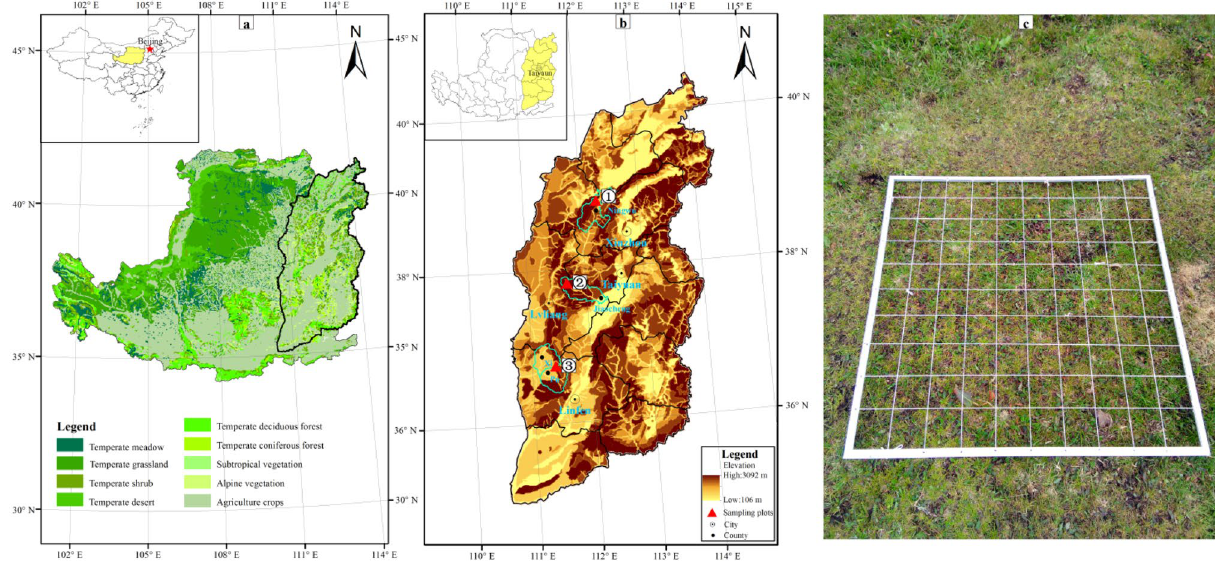
and 4 elevations were observed at Guancen Mountain ( ① ), Guandi Mountain ( ② ), and Wulu Mountain ( ③ ), respectively. In the interior of the frame, 100 grids were separated to accurately measure plant frequency and coverage. ( a ) and ( b ) were created by using ArcMap 10.2 (https:// deskt op. arcgis. com/ zh- cn/ arcmap/) in the